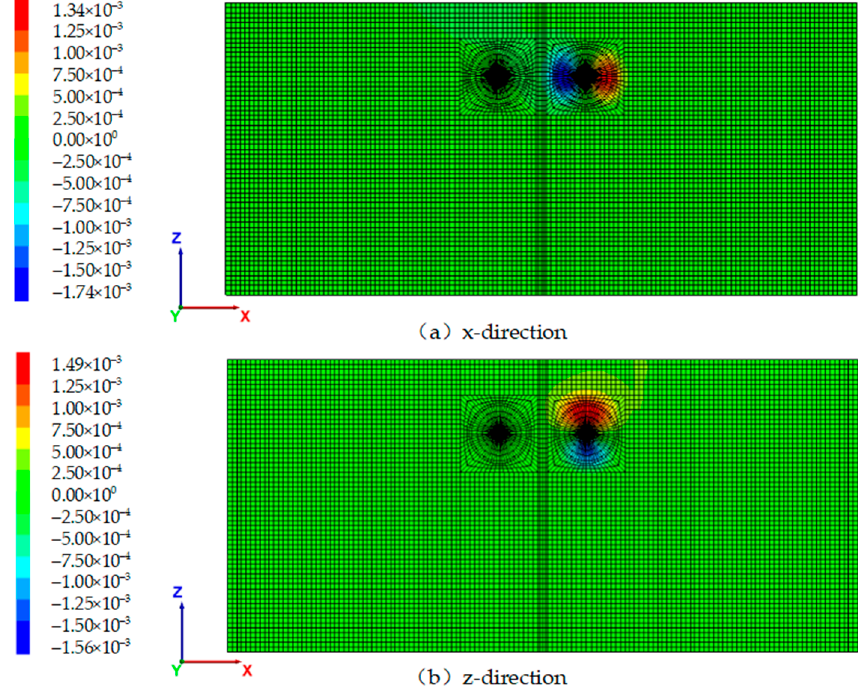
Figure 11. The displacement contour of the portal with the real reinforcement method (unit: m).